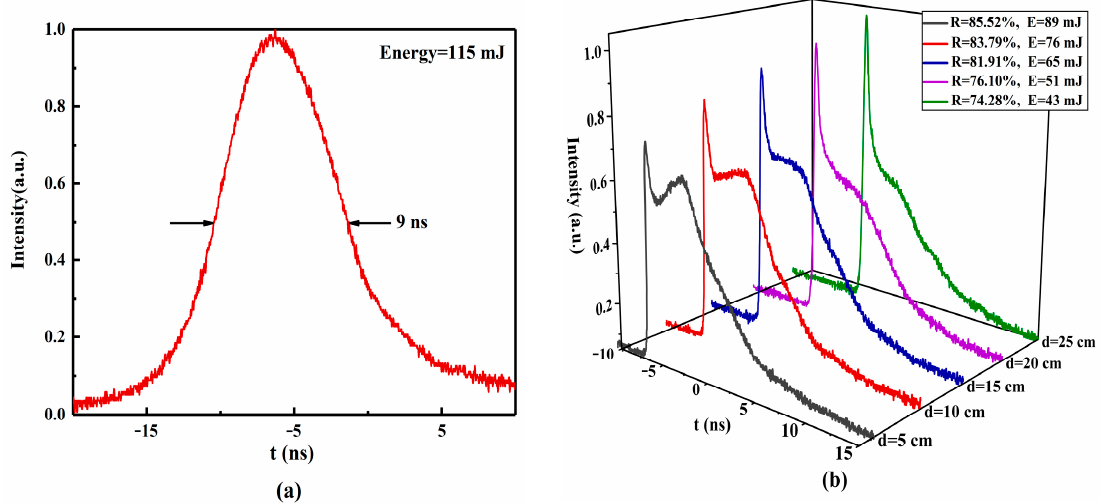
Figure 5. Experimental temporal pump and Stokes waveform: ( a ) pump with a temporal Gaussian waveform; ( b ) evolution of Stokes temporal waveform with varying interaction lengths between Stokes and the pump.